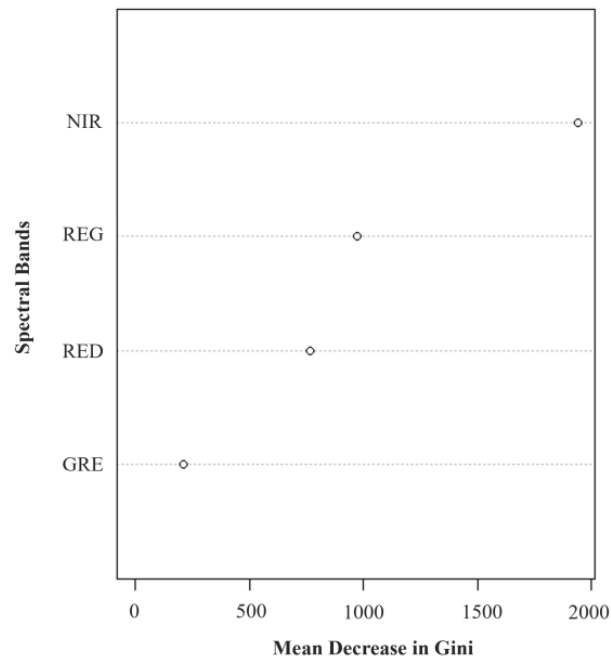
Figure 6. Importance variables by Mean Decrease in Gini in spectral bands.